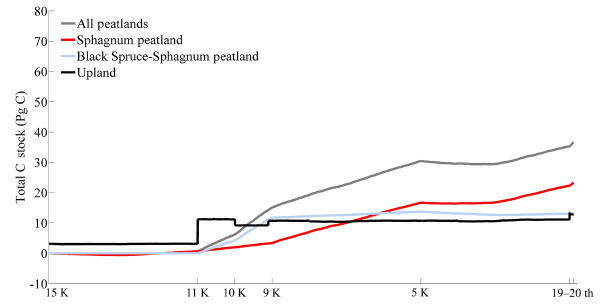
Figure 11. Total C stock accumulated from 15ka to 2000AD for all peatlands, Sphagnum open peatlands, Sphagnum –black spruce peatlands, and upland